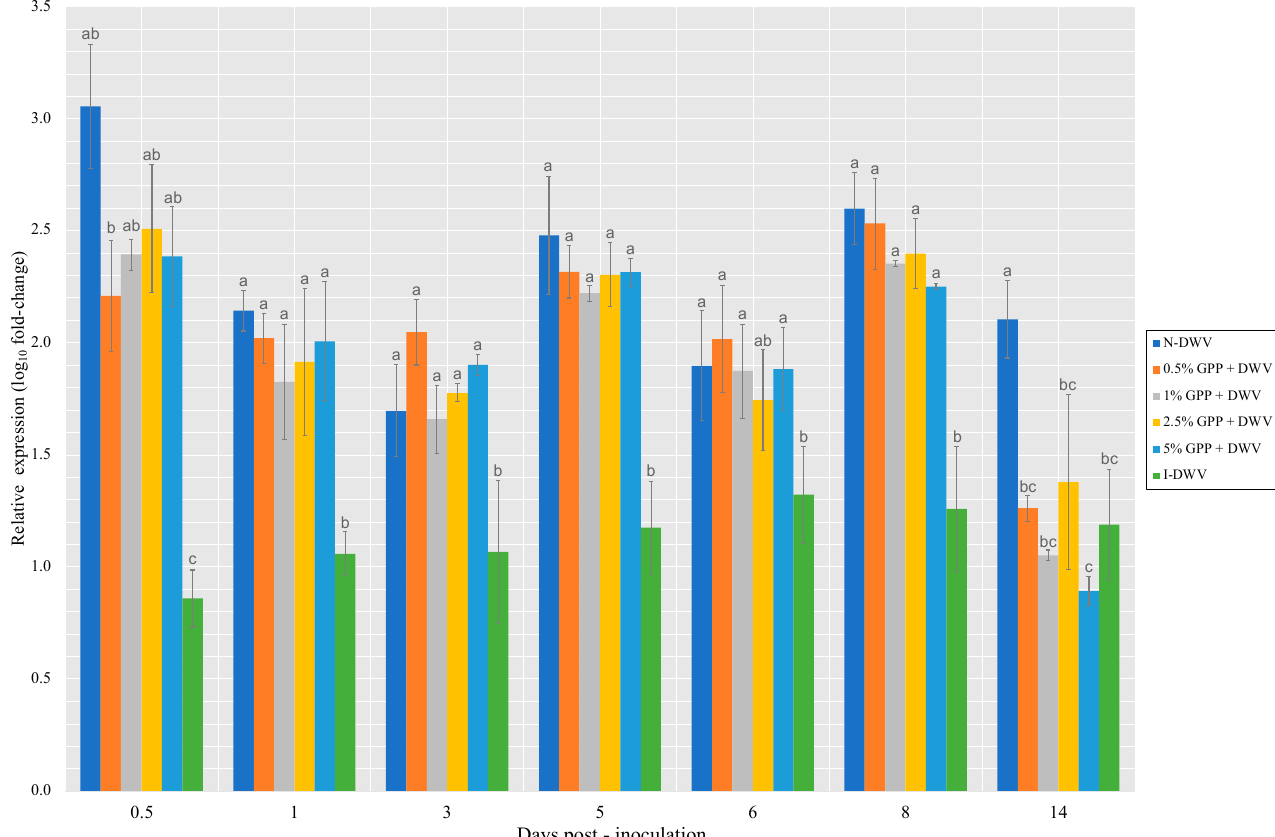
Figure 7. Expression level of Relish gene involved in the Imd pathway in worker honeybees per collection throughout the assay. Grape pomace powder (GPP) concentrations (0.5, 1, 2.5 and 5%), inoculated control (I-DWV), and non-inoculated control (N-DWV). Different letters indicate significant differences according to a Tukey’s test ( p < 0.005).